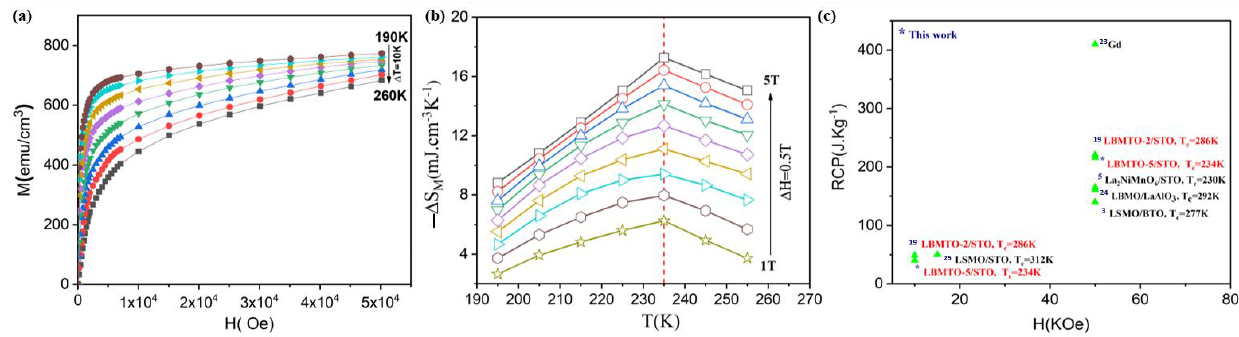
Figure 3. The magnetic properties and magnetocaloric effect of the LBMTO-5/STO(001) film. ( a ) Isothermal magnetization curves measured at different temperatures around T C . Inset shows the Arrott plot of µ 0 H/M versus M 2 . ( b ) Temperature dependence of the magnetic entropy change ( ∆ S M ) under different applied magnetic fields. ( c ) Relative cooling power (RCP) as a function of the applied magnetic field compared with several other magnetic refrigerants thin films from the literature. The corresponding references [3,5,19,23–25] are marked in the left side of each material.